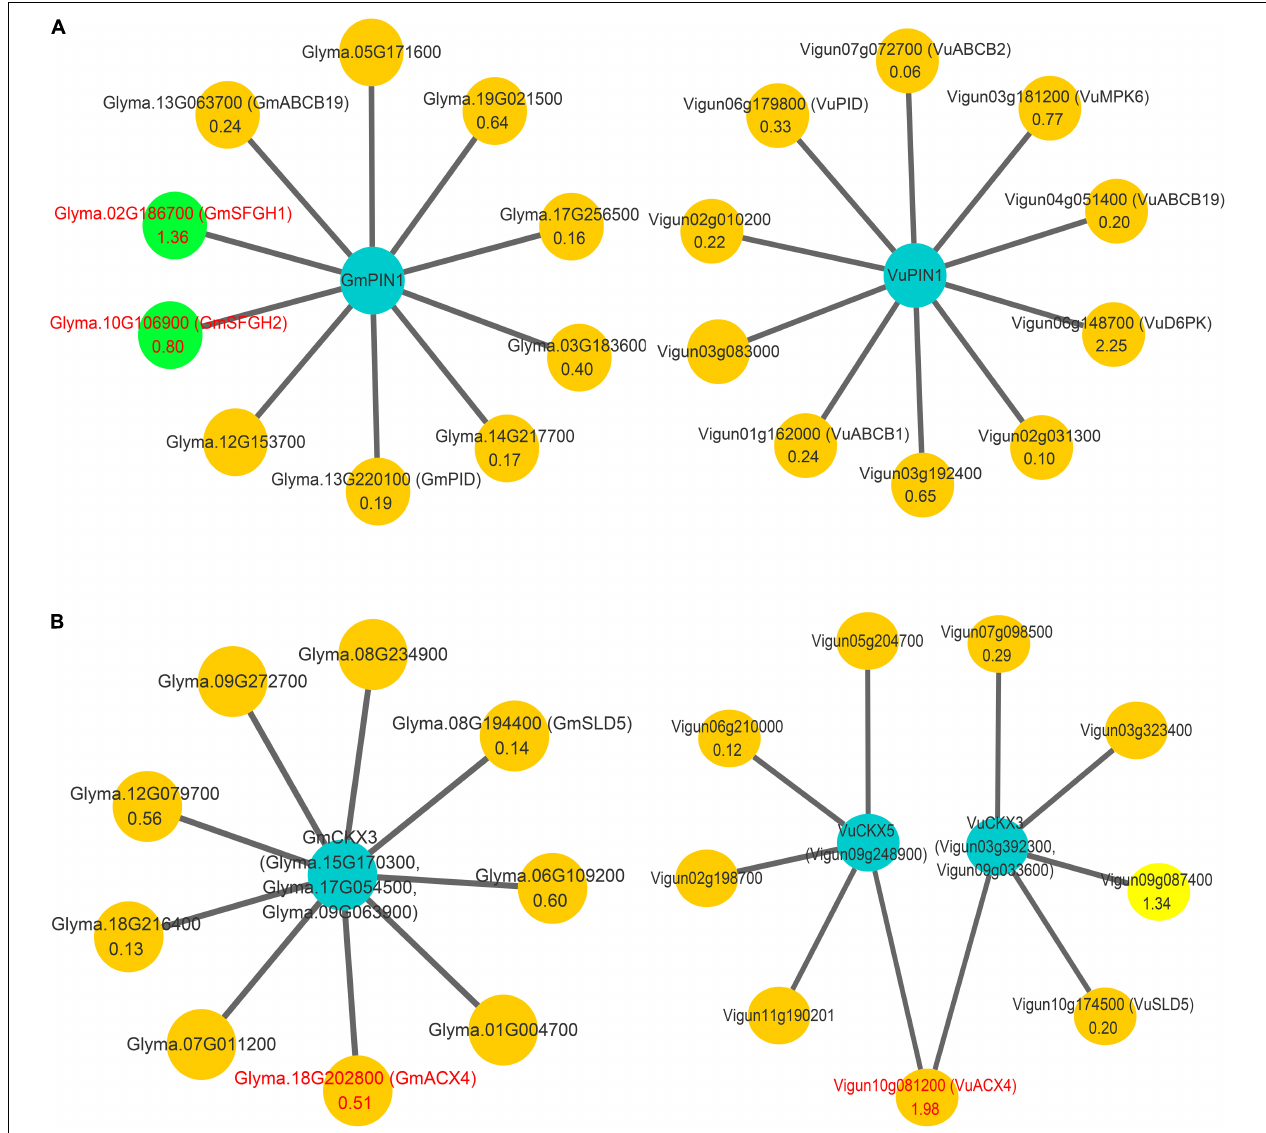
FIGURE 2 | The interaction networks on PIN1 , CKX3 , and CKX5 in soybean and cowpea. (A) The interaction networks on GmPIN1 and VuPIN1 . (B) The interaction networks on GmCKX3 , VuCKX3 , and VuCKX5 . All the genes that encode serine hydrolase in soybean and short-chain acyl-CoA oxidase in cowpea were marked by red color and green